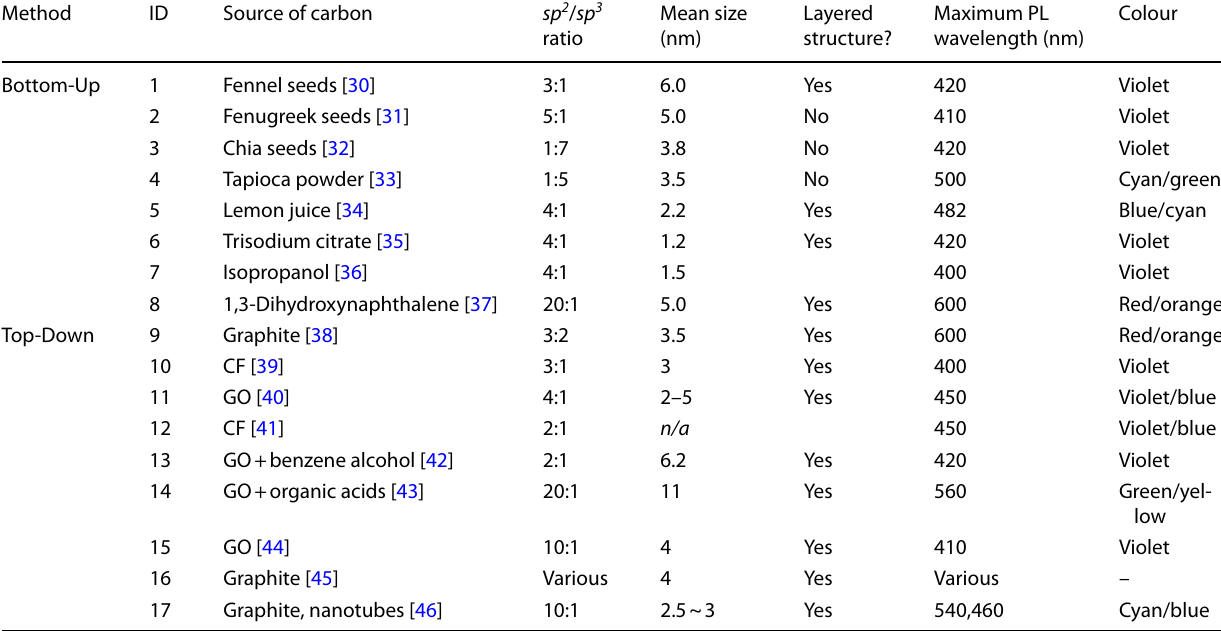
Table 1 Summary of methods of production, source of carbon, sp 2 / sp 3 ratio of carbon atoms in central parts of the graphenic sheets as estimated from X-ray photoelectron spectroscopy (XPS), mean carbon quantum dot (CQD) size, presence or absence of an observed layered structure in TEM images, and wavelength of the photoluminescence maximum for experimentally characterised nitrogen-free